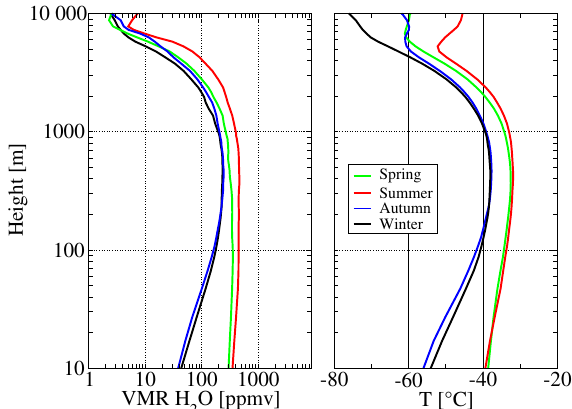
Figure 3. The four seasonal climatological profiles of water vapour VMR (left panel) and temperature (right panel) used as initial guesses in the fitting procedure.